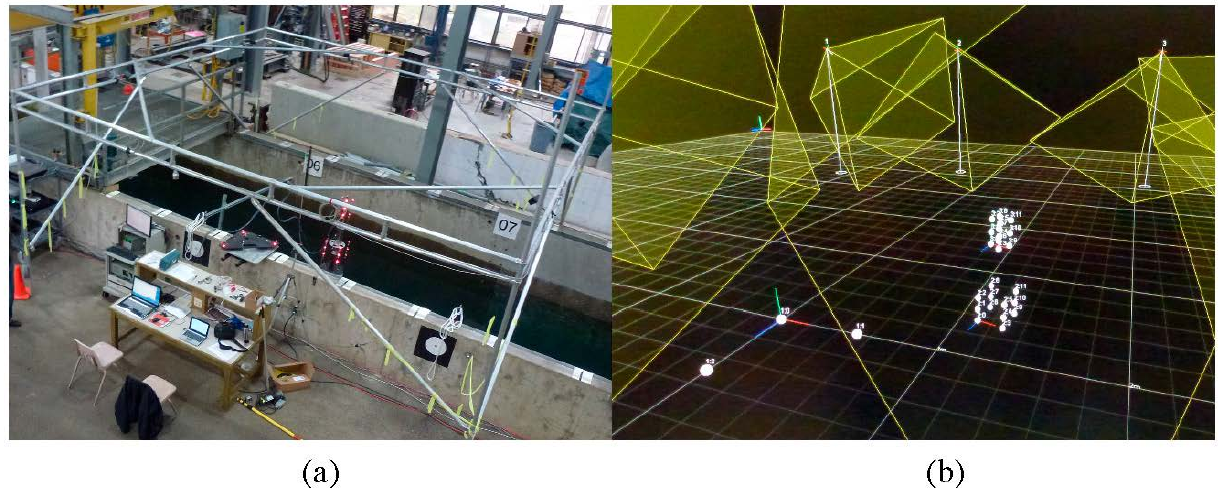
Figure 7. Optical motion tracking: ( a ) Setup in the O.H. Hinsdale Wave Research Laboratory (HWRL); and ( b ) screen capture of tracking